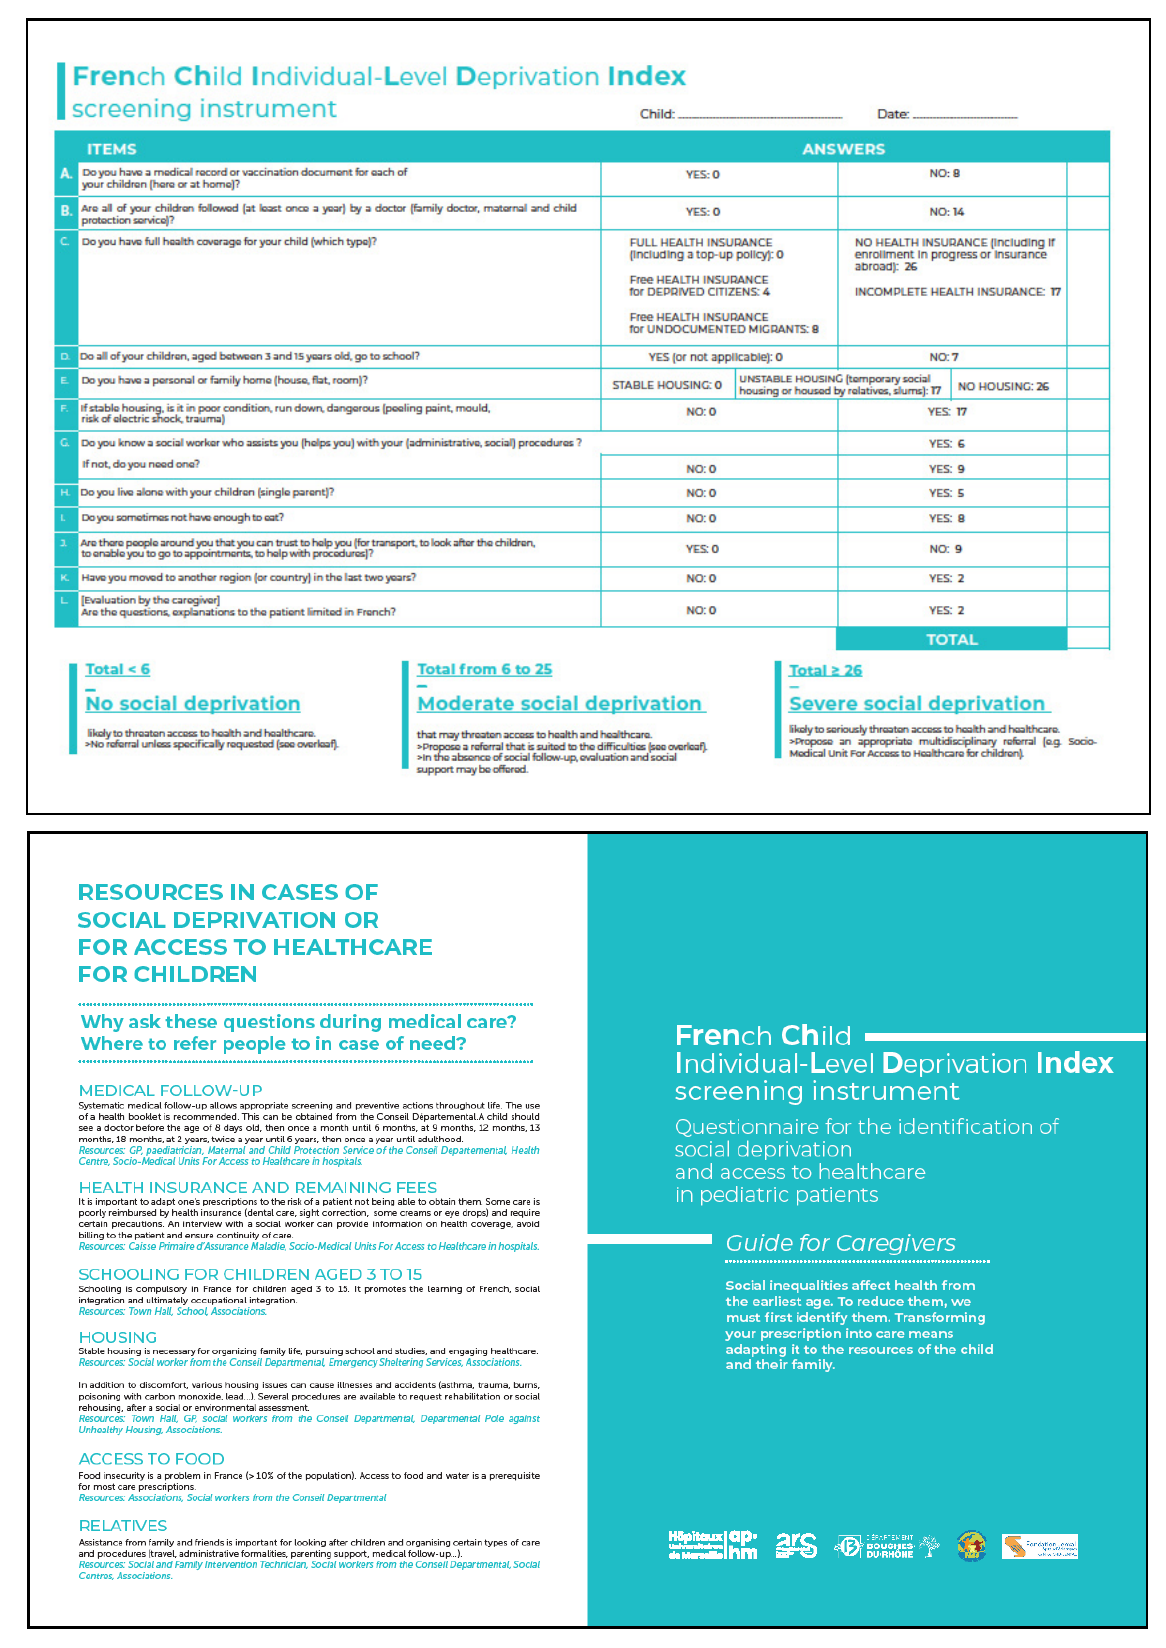
Figure 2. French Child Individual-Level Deprivation Index screening instrument (English transla- tion).